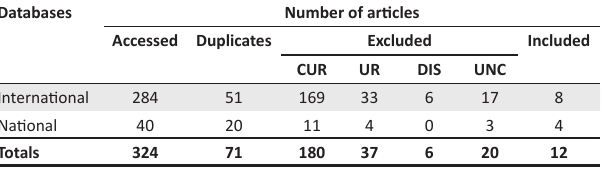
TABLE 3: Literature search tracking